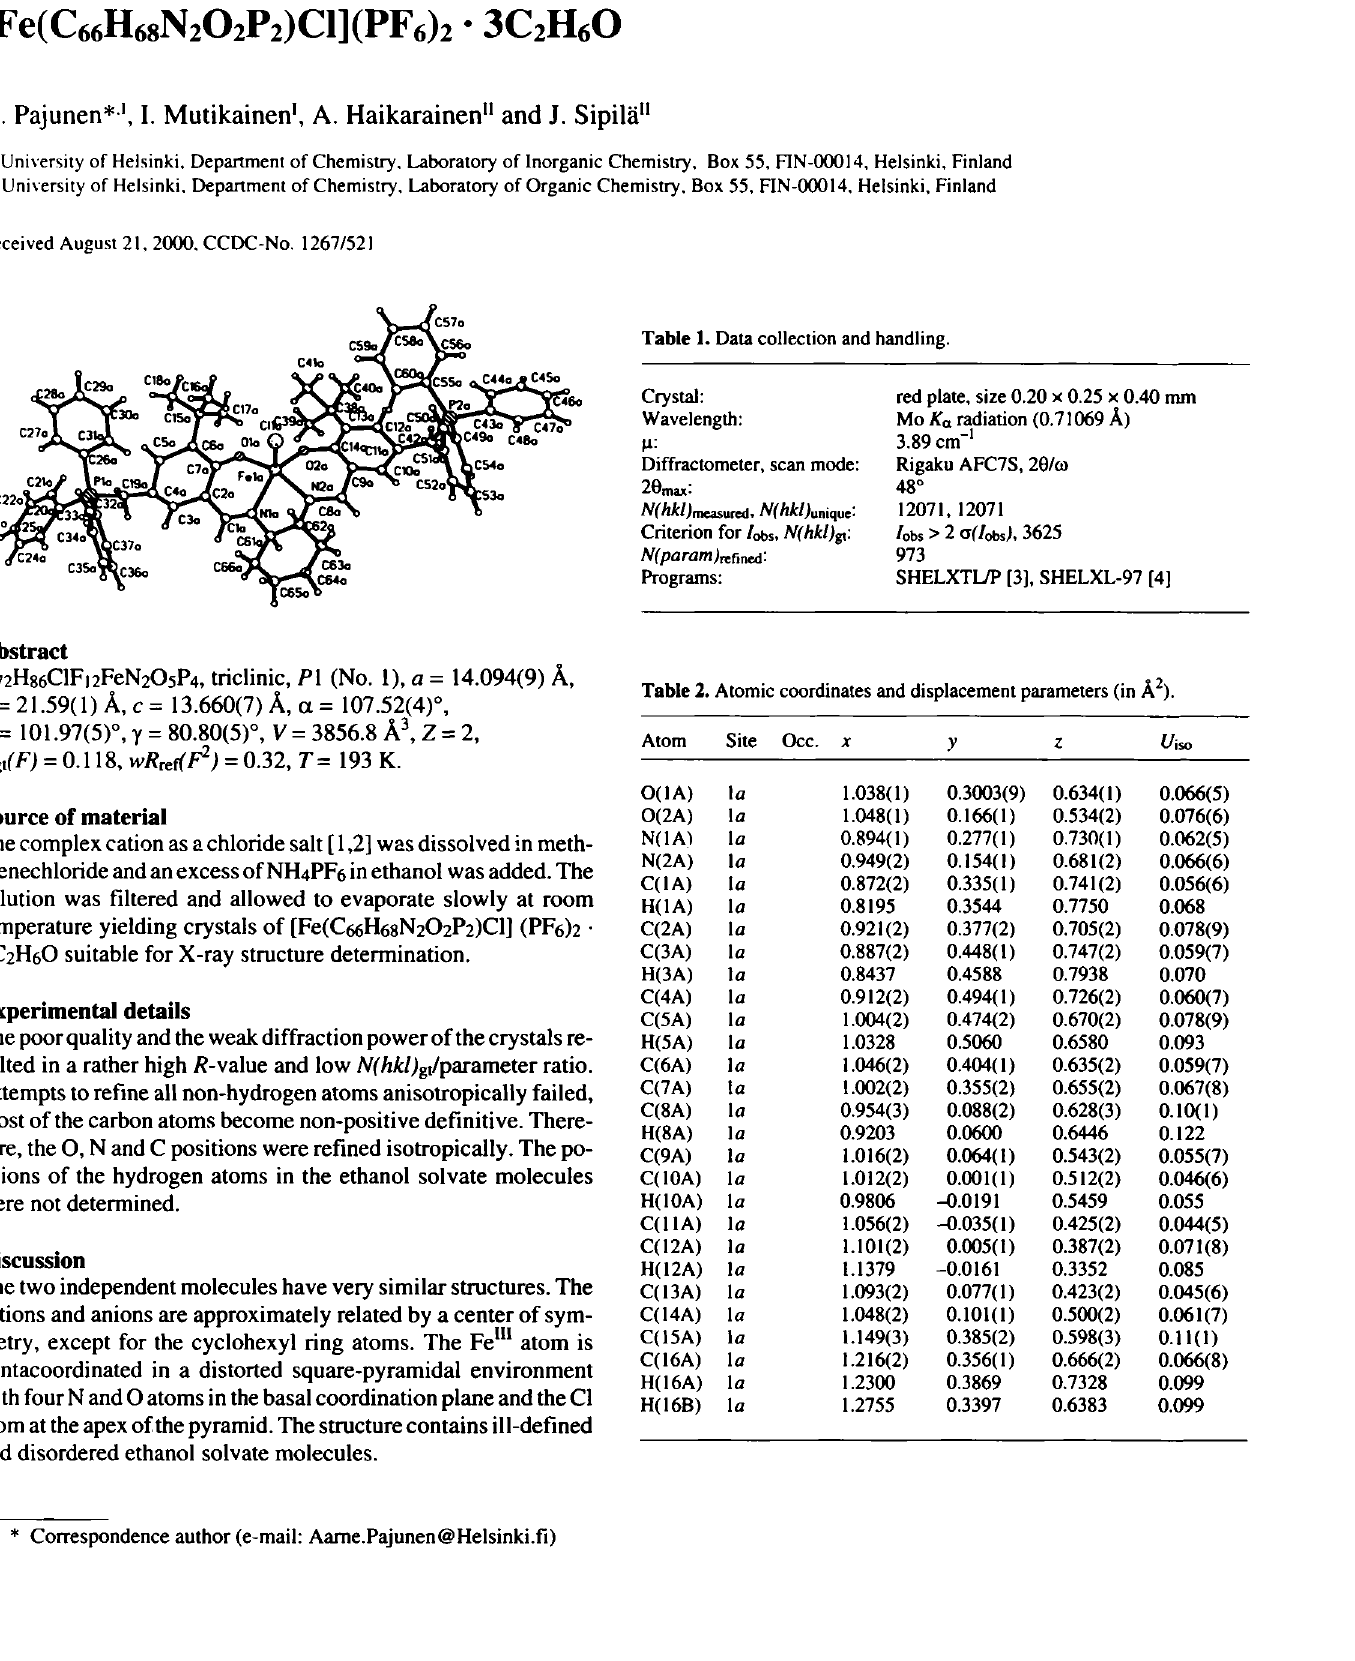
Table 1. Data collection and handling.